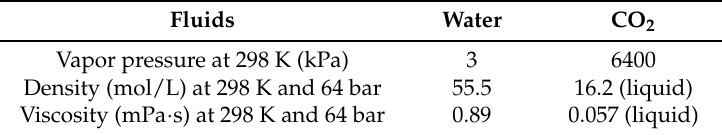
Table 1. Properties of CO 2 and water used in the experiment.